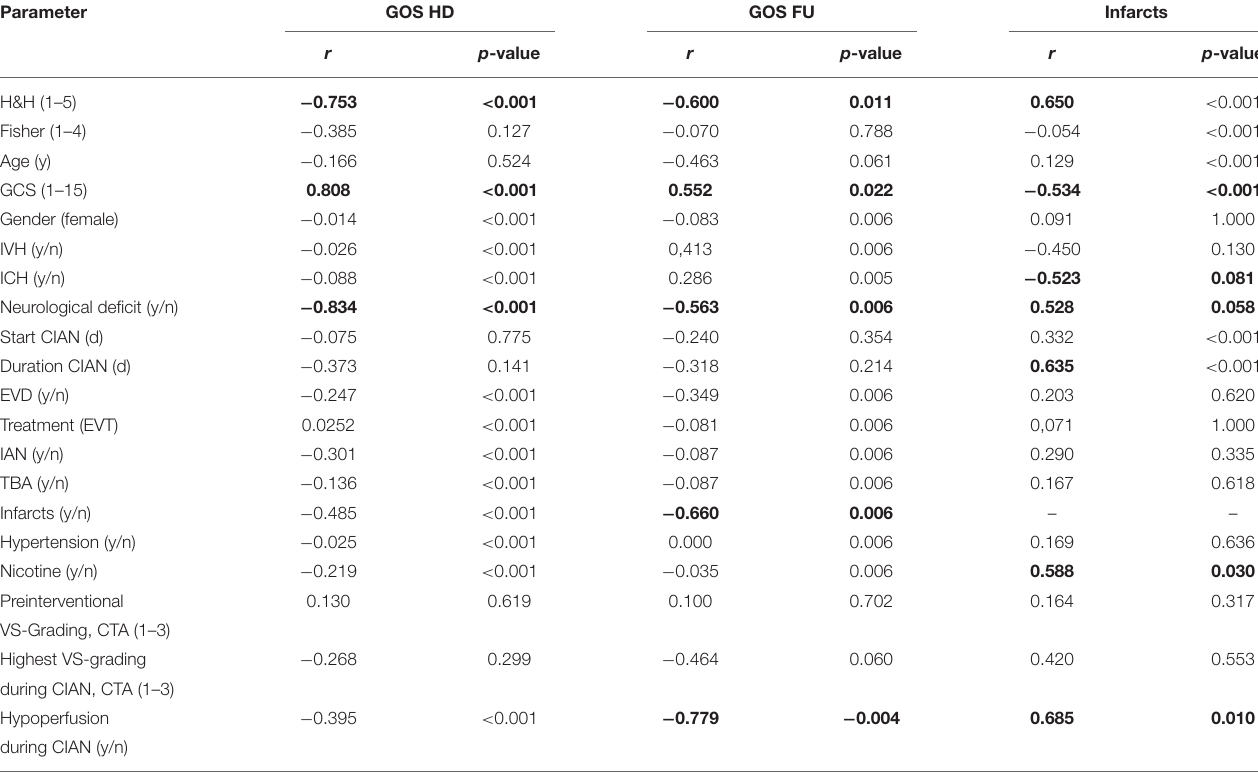
TABLE 3 | Statistical analyses of outcome parameters. Parameter GOS HD GOS